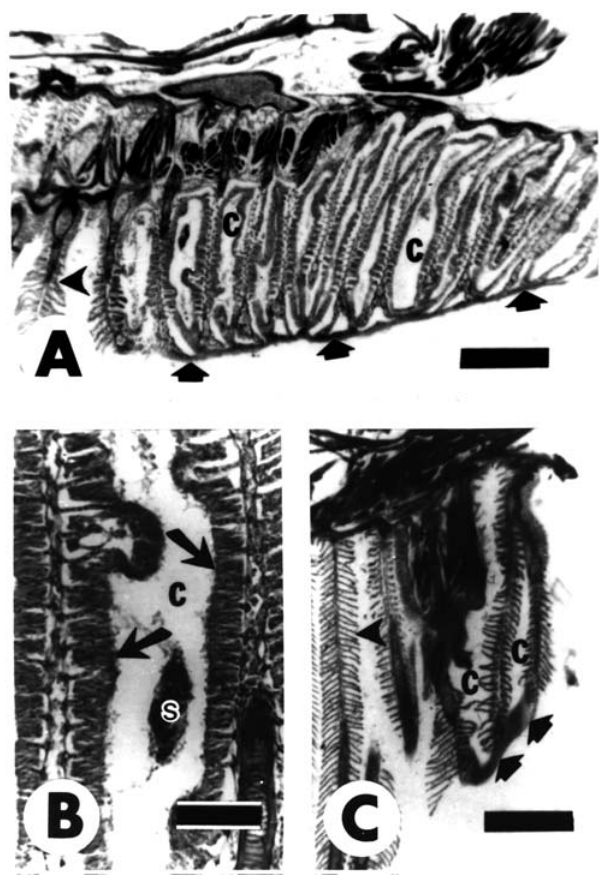
Fig. 19. Light micrographs through gill glands. A, male Attonitus bounites , SL 43.0 mm (USNM 349701), longitudinal section through gill gland showing the ventral epithelium (arrows) that results in the formation of gill gland chambers (c); arrowhead indicates an unmodified gill filament; bar, 200 µ m. B, same specimen showing tall columnar cells (arrows) in between re- duced secondary lamellae; s, secretory material; bar, 50 µ m. C, male A . irisae , SL 46.1 mm (USNM 349698), longitudinal sec- tion through immature gill gland showing the epithelium (ar- rows) covering the gland chambers (c); bar, 200 µ